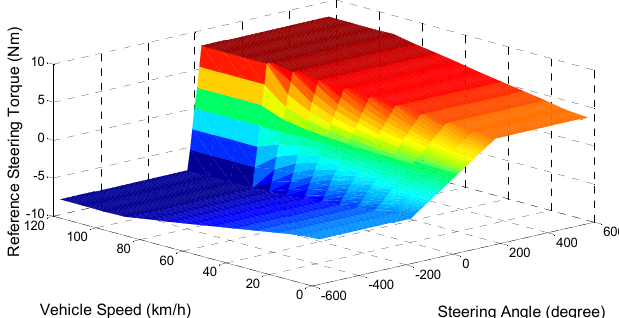
Figure 8. The ideal steering wheel torque map.